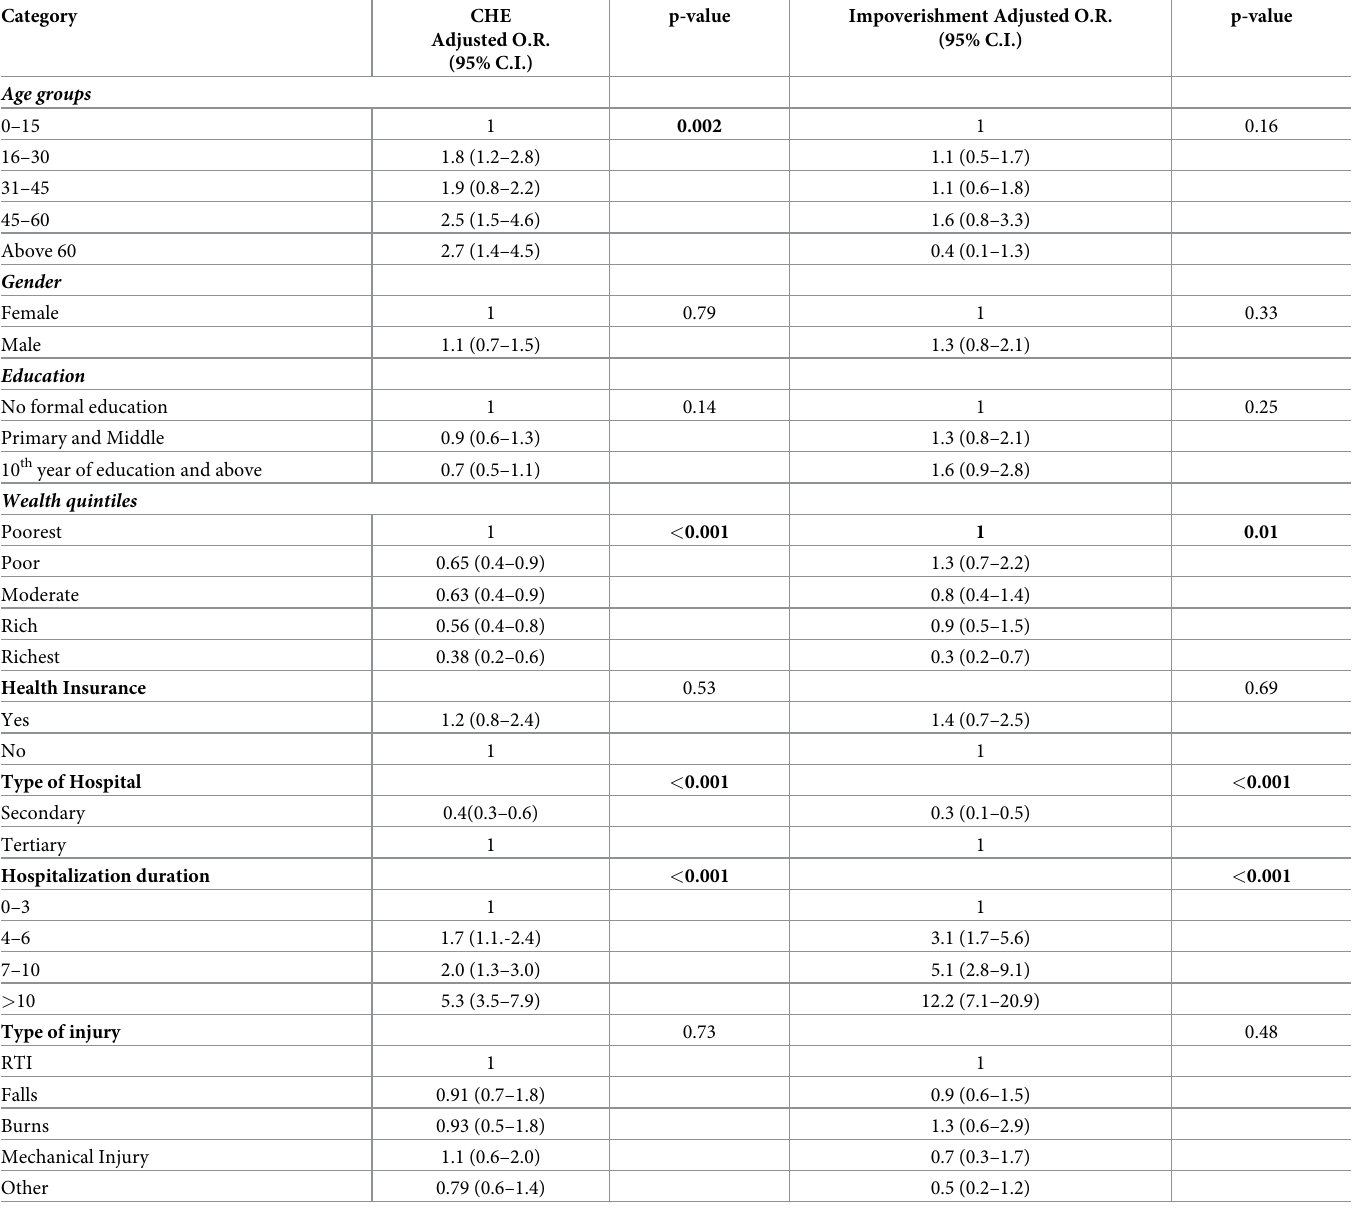
Table 6. Determinants of catastrophic health expenditure and impoverishment for injury-related hospitalization. Category CHE Adjusted